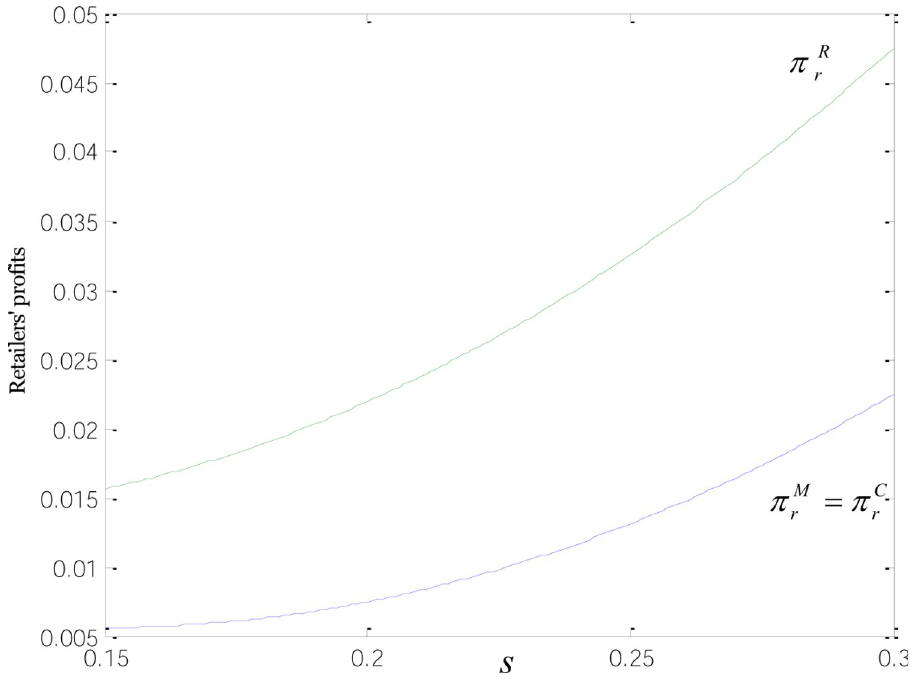
Fig 6. Relationships between retailers’ profits and low-carbon